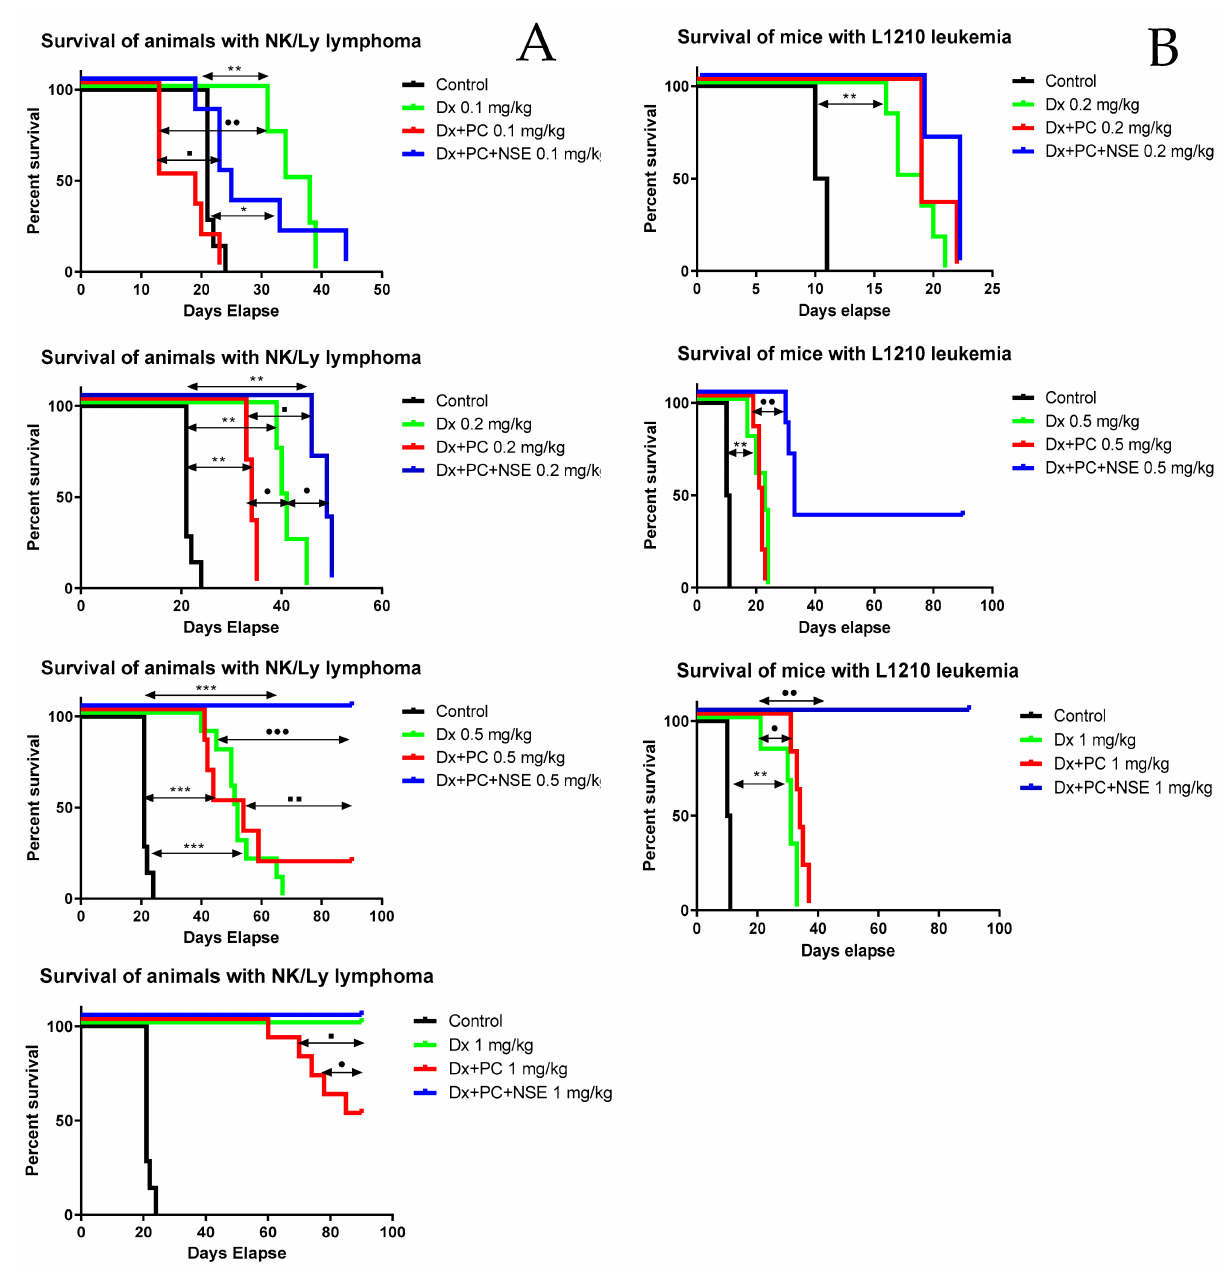
Figure 10. Impact of co-immobilization of Dx and NSE on survival of mice bearing NK/Ly lymphoma ( A ) and L1210 leukemia ( B ), respectively. Significance to other treatments was calculated by Mantel– Cox test (* p < 0.05; ** p < 0.01; *** p < 0.001 relative to control, • p < 0.05; •• p < 0.01; ••• p < 0.001 relative to Dx, (cid:110) p < 0.05; (cid:110) (cid:110) p < 0.01 relative to